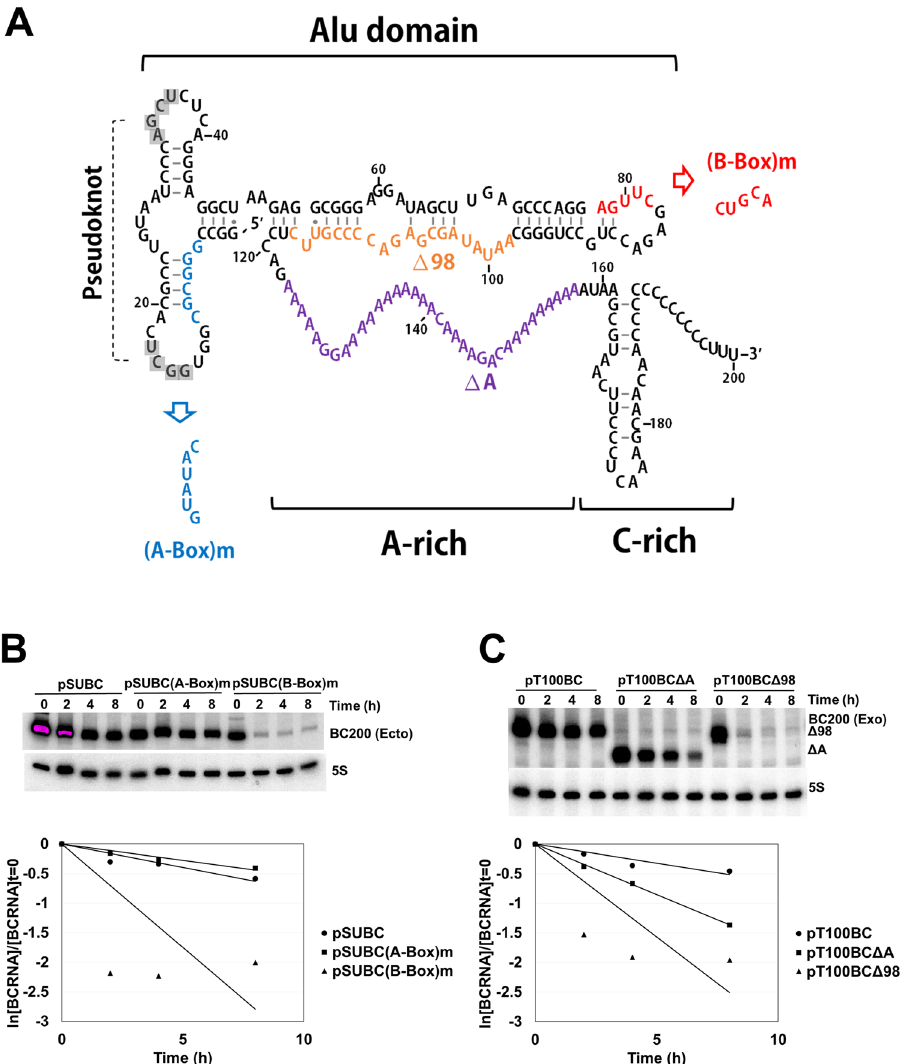
Figure 7. Half-lives of BC200 RNA deletion or mutant derivatives. ( A ) Schematic diagrams of BC200 RNA (nts 1–200). Deleted sequences were shown in orange for RNA Δ 98-117 and purple for RNA Δ A. Mutated sequences were also shown in blue for RNA(A-Box)m and red for RNA(B-Box)m. Alu domain (nts 1–122), A-rich region (nts 123–158) and C-rich region (nts 159–200) were indicated. Total cellular RNA was isolated from HeLa cells transfected with − 100 nt upstream constructs expressing BC200 RNA mutants or deletion derivatives, and the half-lives of the BC200 RNA mutant ( B ) or deletion ( C ) derivatives were analyzed as described in the legend to Fig. 6. The cells were transfected with 1 µ g of plasmids expressing BC200 RNA or its derivatives. The remaining BC200 RNA levels (ln[BC200]/[BC200]t = 0) are also plotted versus time in hours. BC200 (Ecto) and BC200 (Exo) stand for ectopic and exogenous BC200 RNA, respectively.